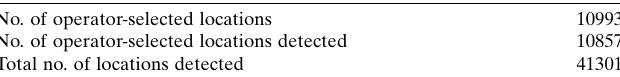
Table 2 Performance metrics of different ML models on the square classification task measured on held-out sessions and held-out square